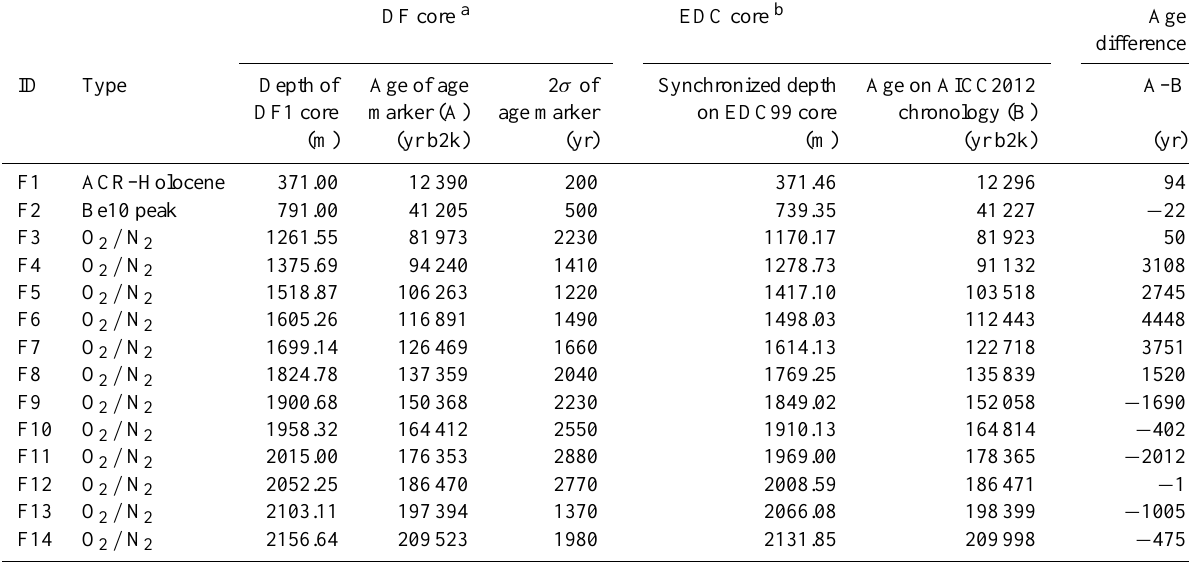
Table 2. Depths and AICC2012 ages of EDC core at depth/age of age markers of DF